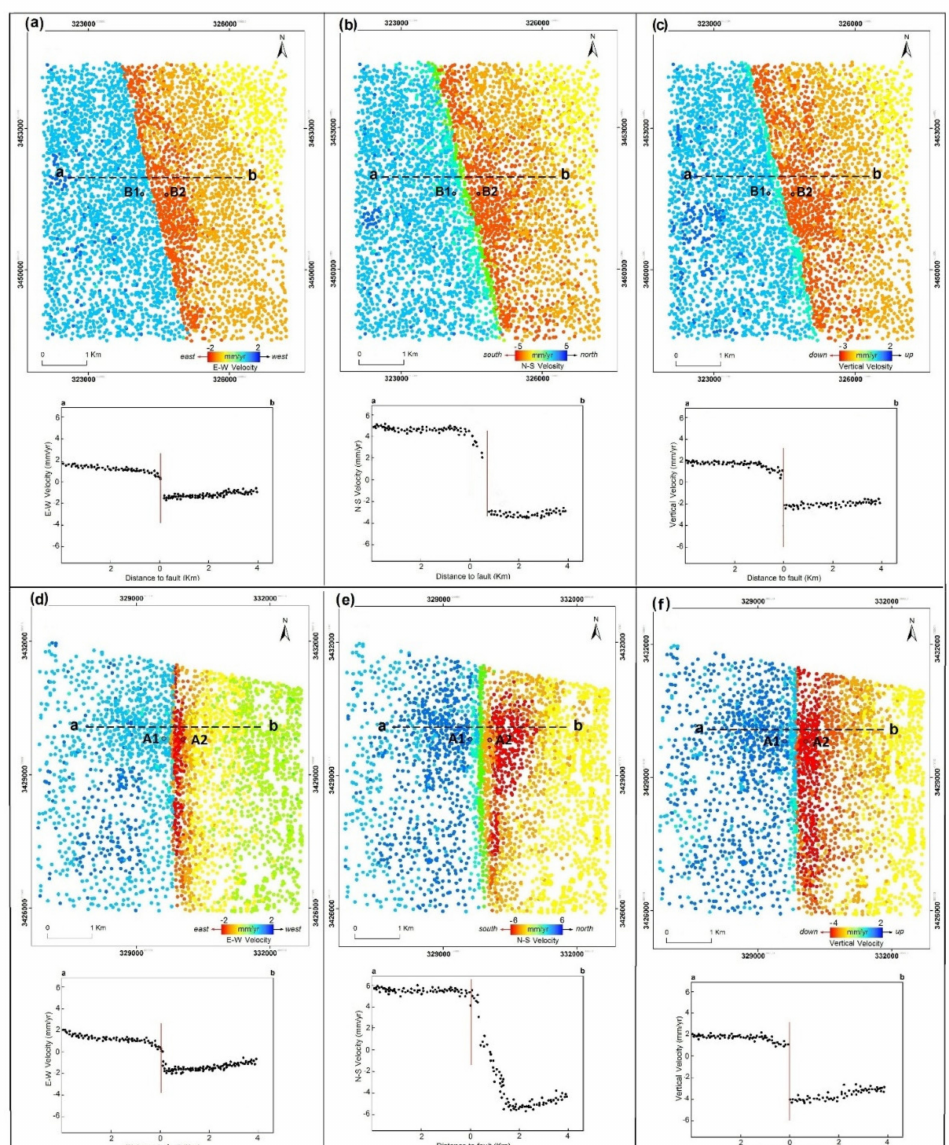
Figure 6. Mechanism of the displacement component (E–W, N–S, and vertical) for the Anar fault activity. Combination of oblique and lateral strike-slip fault. Velocity component and displacement profiles ( a , d ) E–W, ( b , e ) N–S, and ( c , f )